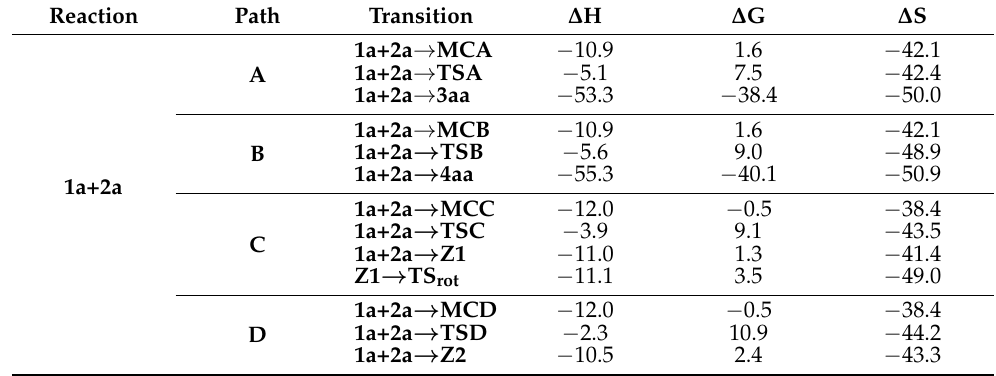
Table 3. DFT kinetic and thermodynamic parameters for the 32Cas of diphenylnitrylimine 1a and (E)-